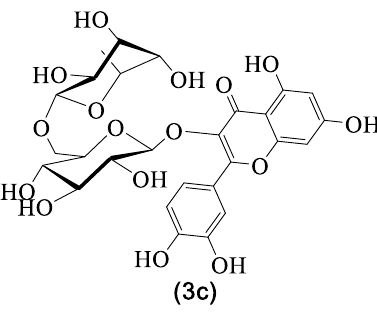
Figure 6. Rutin 3c Figure 6. Rutin 3c structure.